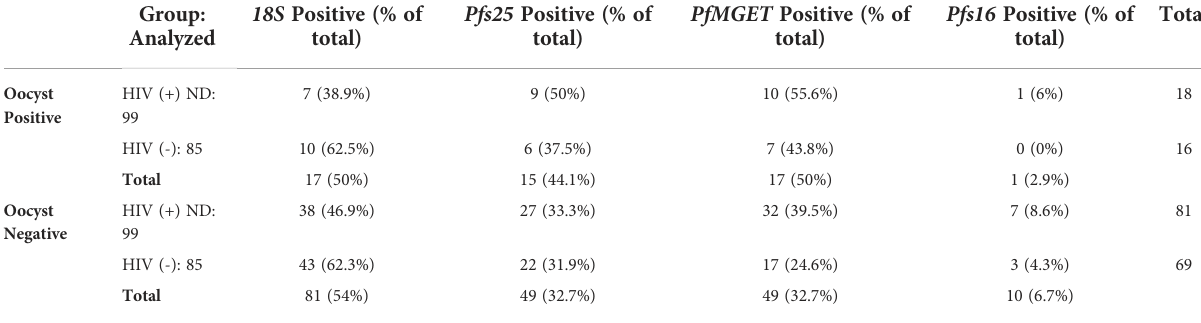
TABLE 2 Oocyst Positivity by Study Group and Molecular Diagnostic Positivity.